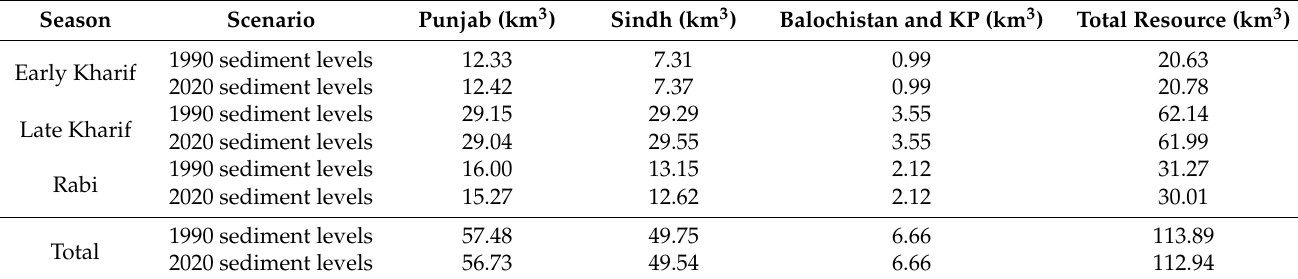
Table 1. 1990 and 2020 scenario reservoir sedimentation shares of available resources.